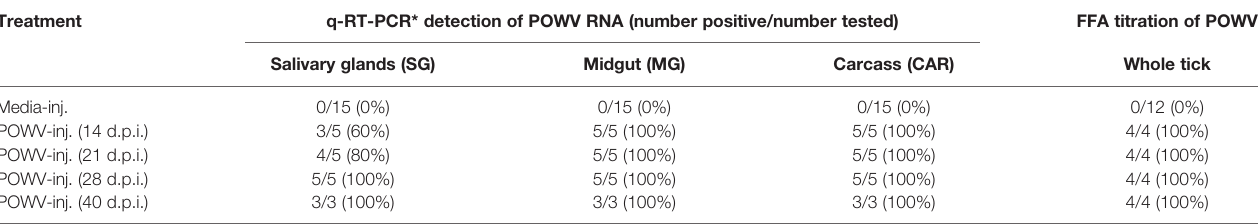
Carcass (CAR) Whole tick